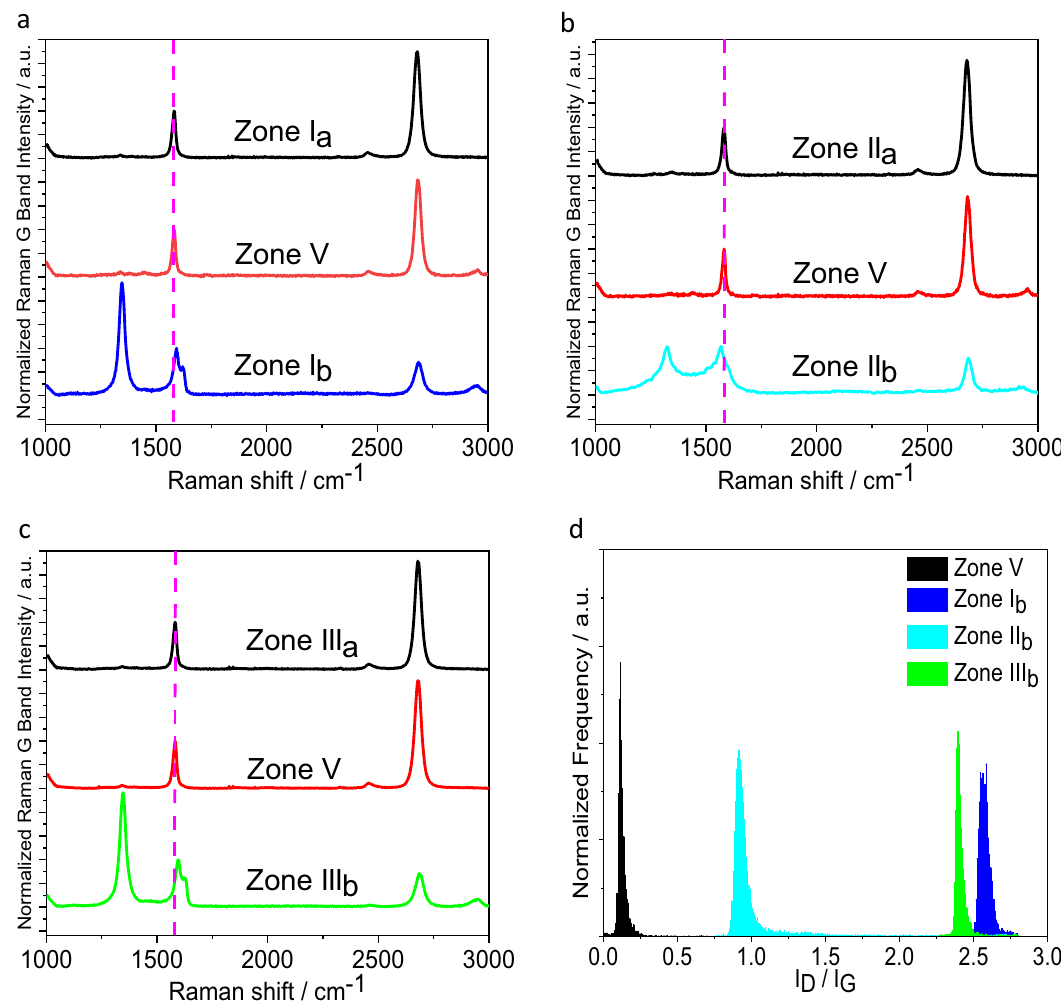
Fig. 2 Statistical Raman analysis of a multiply patterned graphene monolayer. a Raman spectra of zone I a (before arylation), zone V (after arylation and PMMA removal) and zone I b (after arylation). b Raman spectra of zone II a (before deuteration), zone V (after deuteration and PMMA removal) and zone II b (after deuteration). c Raman spectra of zone III a (before chlorination), zone V (after chlorination and PMMA removal) and zone III b (after chlorination). d Statistical Raman histograms of I D / I G ratio extracted from Raman spectra of: ( a ) zone I b (blue), ( b ) zone II b (cyan), ( c ) zone III b (green), and ( d ) zone V (black). I D / I G : Raman D-band to G-band intensity ratio. Averaged spectra ( ∼ 200 single point spectra) of the respective zones, λ exc = 532